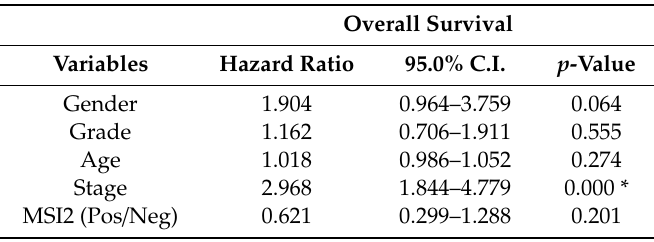
Table 5. Multivariate Cox regression analysis for MSI2 adjusted for other clinic-pathological parameters. * p <